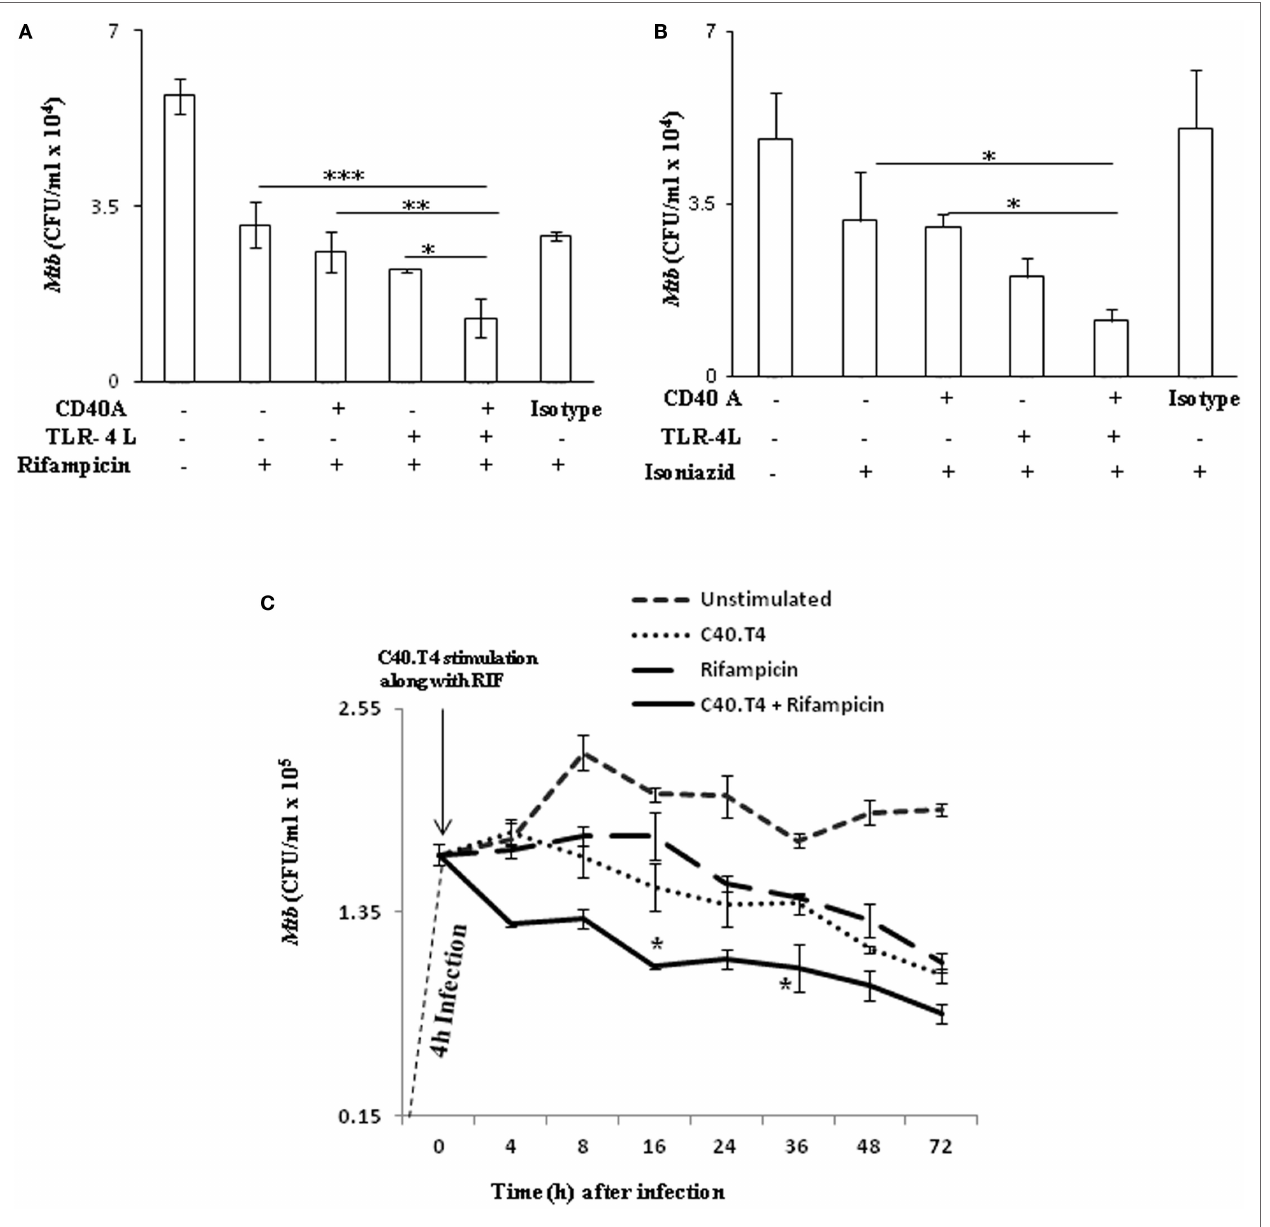
FigUre 5 | c40.T4 triggering enhances the potency of riF and inh to kill intracellular Mtb . DCs infected with Mtb were stimulated through the indicated combinations of C40.T4, CD40, TLR-4 with (a) RIF (24 h) (B) INH (24 h); (c) RIF (0–72 h). Later, cells were lysed and CFUs were monitored on 21 days. Data represented as mean ± SD (a–c) are of three independent experiments. “*,” “**,” and “***” indicate p < 0.05, p < 0.01, and p < 0.001,